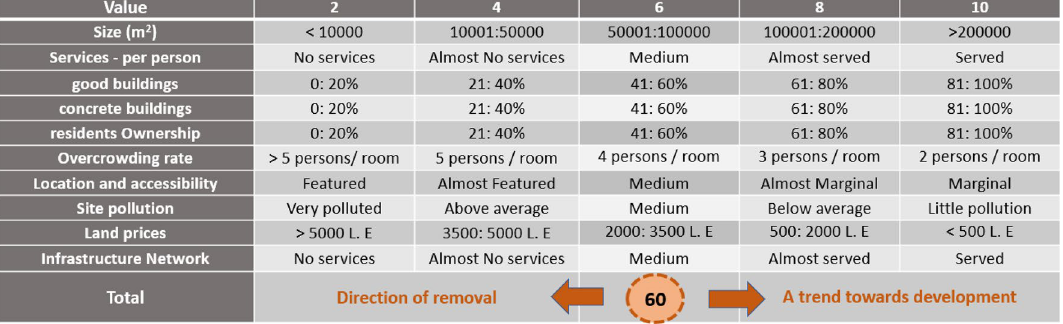
Table 5 Matrix defining the intervention policy (Source: “Tools and Methods of Dealing with Degraded Areas and Slums", Training Course in Urban Planning and Local Economy Development, United Nations Human Settlements Program,